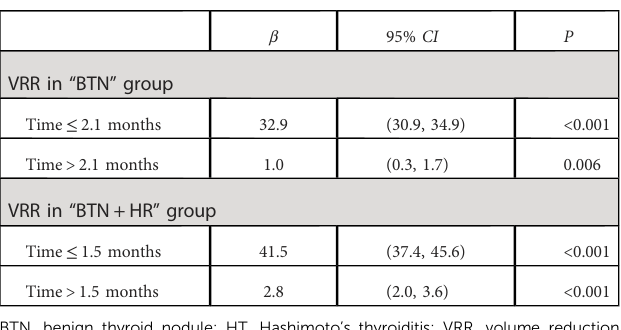
TABLE 2 Threshold effect for the relationship of follow-up time with VRR using piece-wise linear